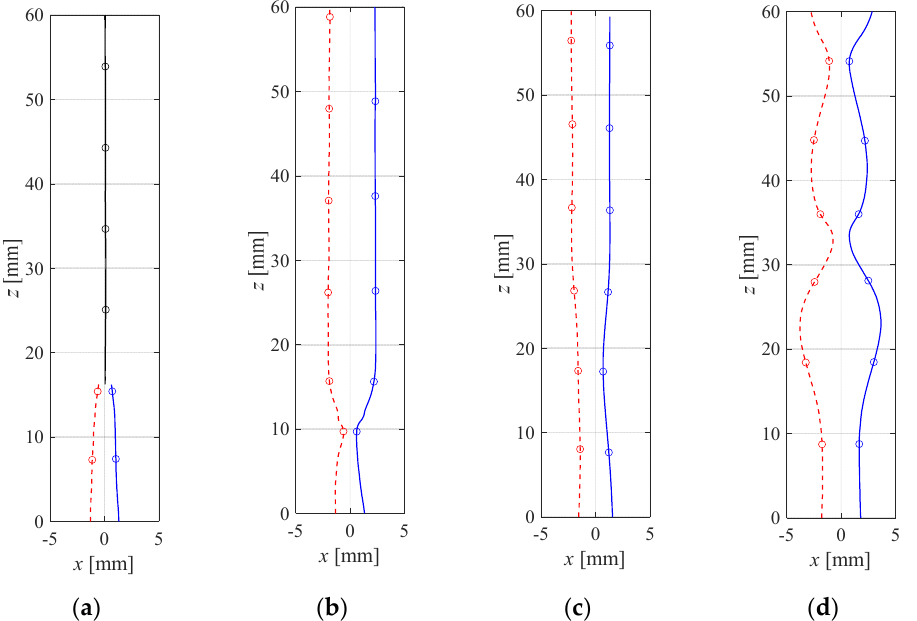
Table 2. Typical trajectories of a pair of bubbles and conditions in experiment.